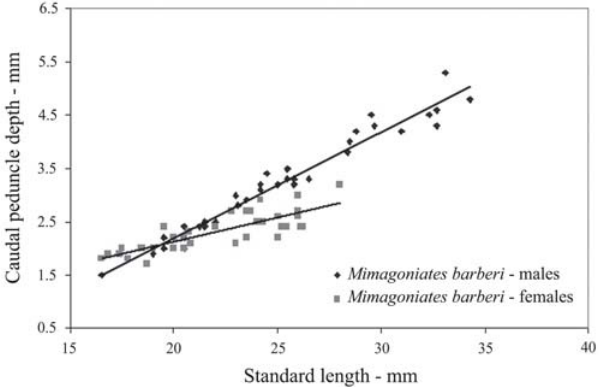
Fig. 44. Mimagoniates barberi , caudal peduncle depth as function of SL by